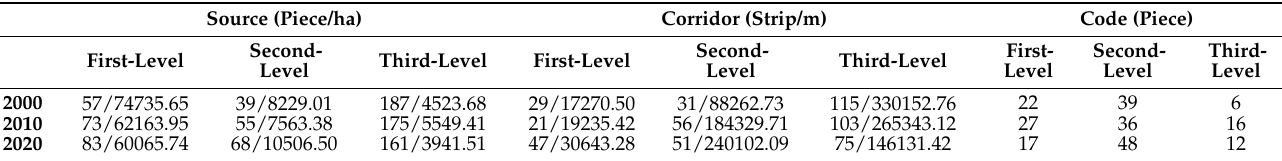
Table 4. The number of GI elements at all levels that changed in 2000, 2010, and